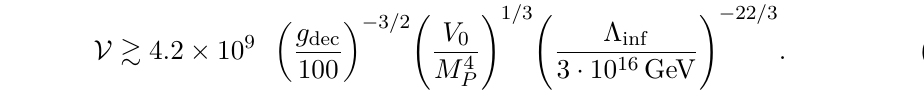
Table 2 . Lower bound for the volume (measured in units of (2 π inflation scale, assuming initial radiation from perturbative decays. The first line conservatively assumes the number of light degrees of freedom the volume can decay to after inflation to be g dec = 1 , while the second and third assume the more aggressive estimates g dec = g SM ' 100 and g dec = 10 4 .